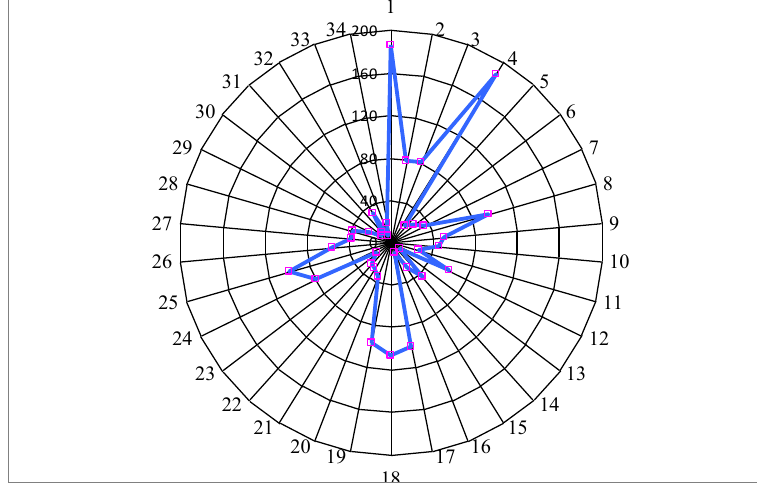
Fig.1. Morphological-functional profile of sportsemn, specializing in breast stroke swimming: 1 – body length (cm), 2 – body weight (kg), 3 – arm’s length (cm), 4 – arm span (cm), 5 – hand’s length (cm), 6 – length of forearm (cm), 7 – length of shoulder (cm), 8 – length of leg (cm), 9 – length of hip (cm), 10 – length of shin (cm), 11 – length of foot (cm), 12 – torso length (cm), 13 – width of foot (cm), 14 – width of shoulders (cm), 15 – width of pelvis (cm), 16 – width of hand (cm), 17 – circumference of chest in rest (cm), 18 – circumference of chest in inhale (cm ), 19 – circumference of chest at exhale (cm), 20 – circumference of tensed arm (cm), 21 – circumference of relaxed arm (cm), 22 – circumference of forearm (cm), 23 – circumference of wrist (cm), 24 – circumference of waist (cm), 25 – circumference of buttocks (cm), 26 – circumference of hip (cm), 27 – circumference of knee (cm), 28 – circumference of shin (cm), 29 – circumference of ankle (cm), 30 – heart beats rate (HBR), in lying position during 10 seconds, (beats), 31 – ЧСС в покое за 10 с (уд), 32 – HBR after load during 10 seconds (beats), 33 – vital capacity of lungs (VCL) (l), 34 – forward bents